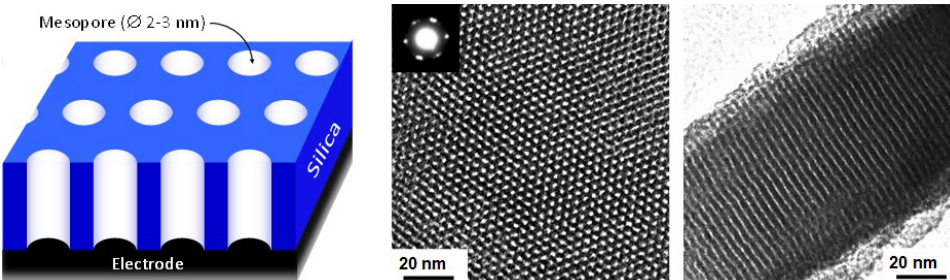
Figure 8. A schematic illustration of a vertically-oriented mesoporous silica film electrogenerated onto an electrode surface and typical corresponding TEM micrographs (top and cross-section